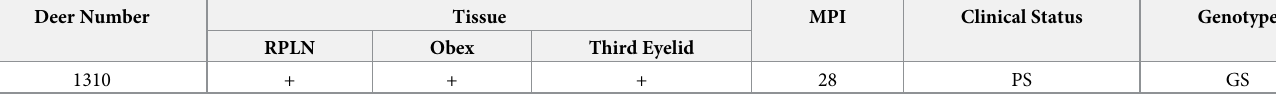
Summary of PrP CWD detection in WTD by RT-QuIC. Data are presented as animals PrP CWD positive or negative by tissue type with respective months post inoculation, clinical status, and PRNP codon 96 genotype: homozygous G96G (GG) and heterozygous G96S (GS), homozygous S96S (SS). Samples were deemed RT-QuIC positive if statistical significance was demonstrated (p < 0.05, two-tailed Mann-Whitney test) when compared with respective negative control tissues. Abbreviations: RPLN, retropharyngeal lymph node; MPI, months post inoculation; PS, pre-symptomatic; S, symptomatic.